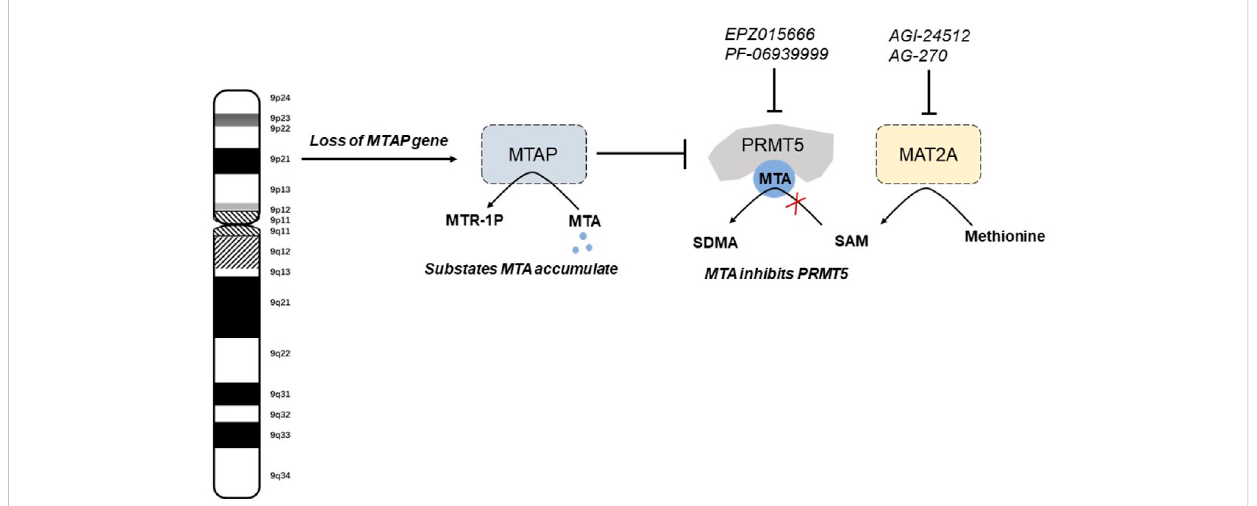
FIGURE 2 The mechanisms of synthetic lethal vulnerabilities in MTAP-deleted tumors. MTA, 5 ′ -methylthioadenosine; MTR-1-P, 5 ′ -methylthioribose-1- phosphate. SAM, S-adenosylmethionine; sDMA, symmetric dimethylarginine.